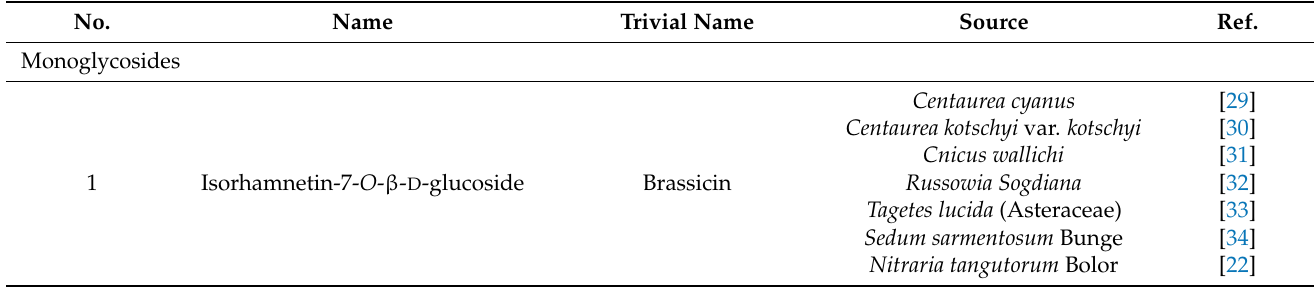
Table 1. Isorhamnetin glycoside (IG) compounds ( 1–49 ). According to the number of sugar